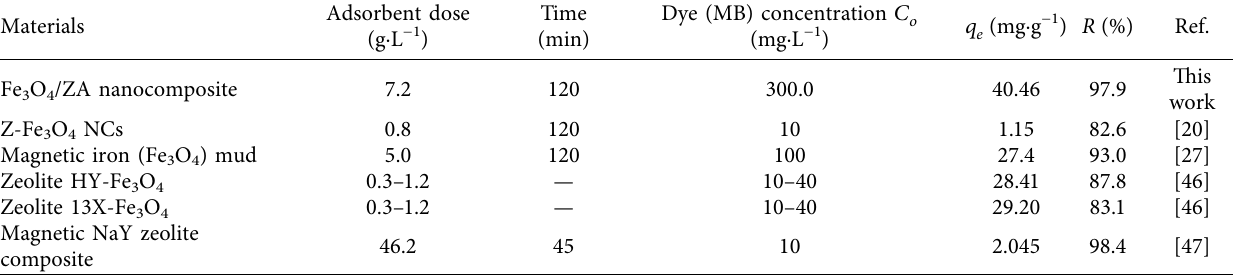
Table 3: Comparison of the maximum adsorption capacity of various adsorbents for MB removal. Adsorbent Materials